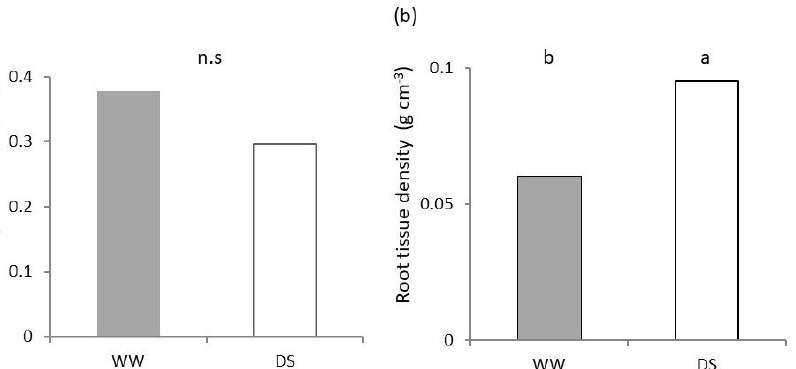
Figure 4. Root architecture of seedlings of Saragolle lucana under different soil water availability. ( a ) Average root diameter; ( b ) root tissue density. Different lowercase letters on each bar designate significantly different values at the Tukey’s post hoc mean separation test for p < 0.05, or non-significant differences (n.s.) for p > 0.05.